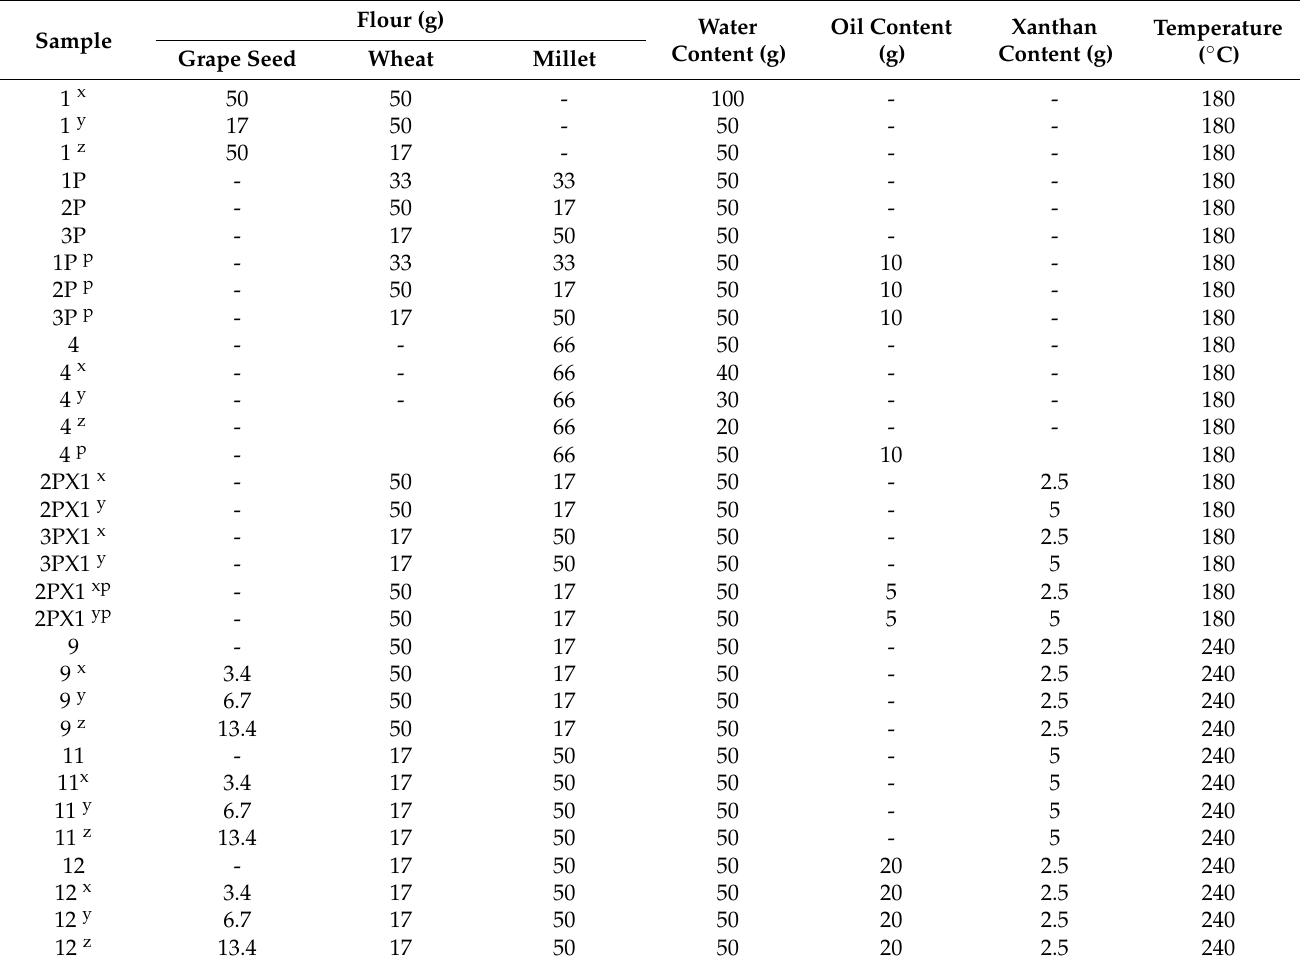
Table 1. Information about biodegradable spoon